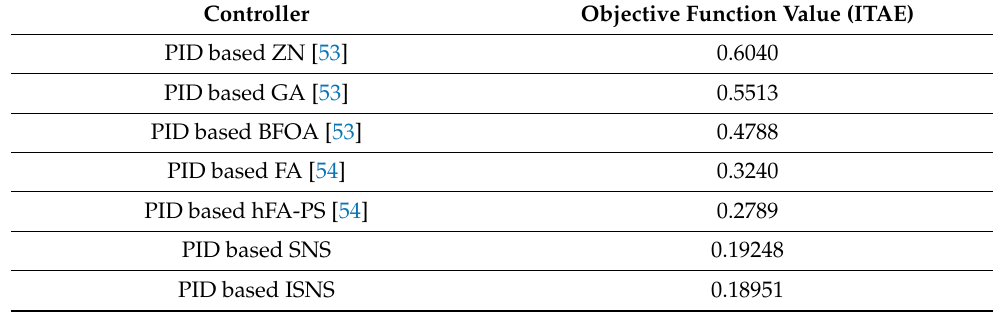
Table 3. The performance indices for PID controllers based different optimization algorithms.